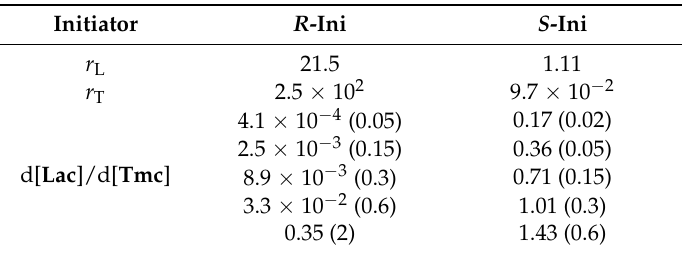
Table 2. The reactivity ratios and relative rates of comonomer consumption a estimated for Lac / Tmc copolymerization systems initiated with R - Ini and S - Ini